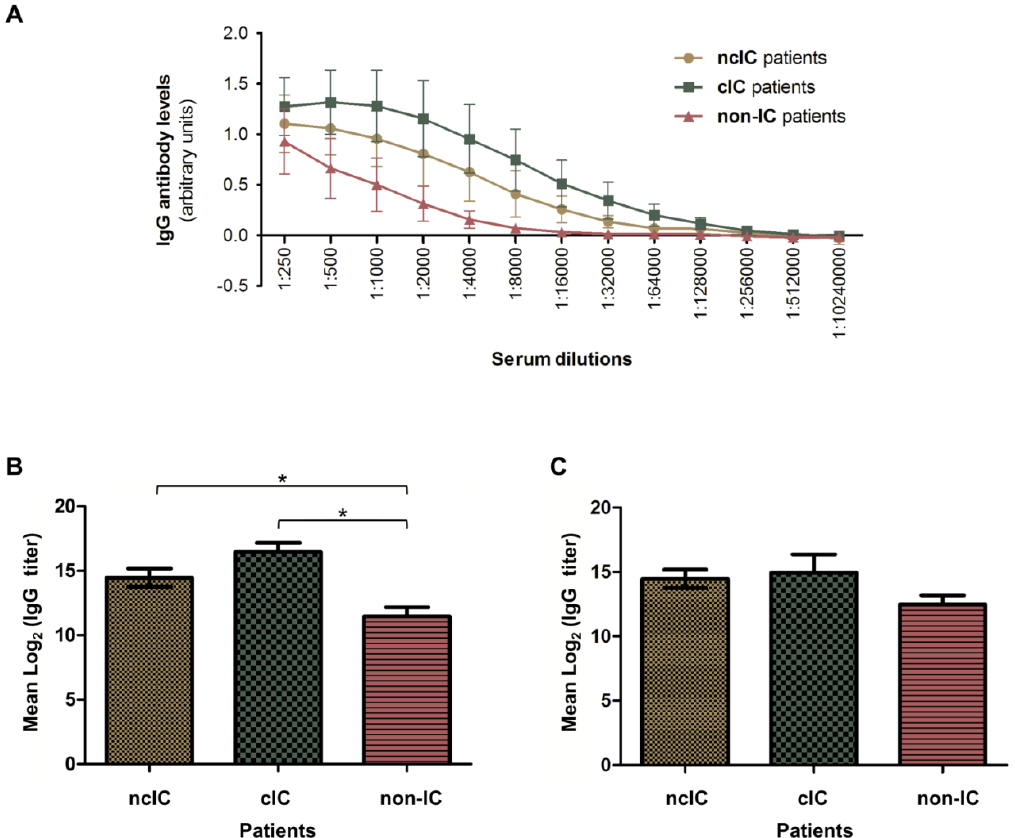
Figure 3. ELISA measurements of IgG antibodies against both C. albicans hyphal secretome batches (S1 and S2) using serum pools from ncIC, cIC and non-IC patients. ( A ) IgG levels to S1 and S2 in the three serum pools at different dilutions. ( B ) Serum titers of IgG antibodies to the C. albicans hyphal secretome in ncIC, cIC and non-IC patients. * p -value < 0.05. ( C ) Serum titers of IgG antibodies to the C. albicans hyphal cytoplasmic proteome in ncIC, cIC and non-IC patients.